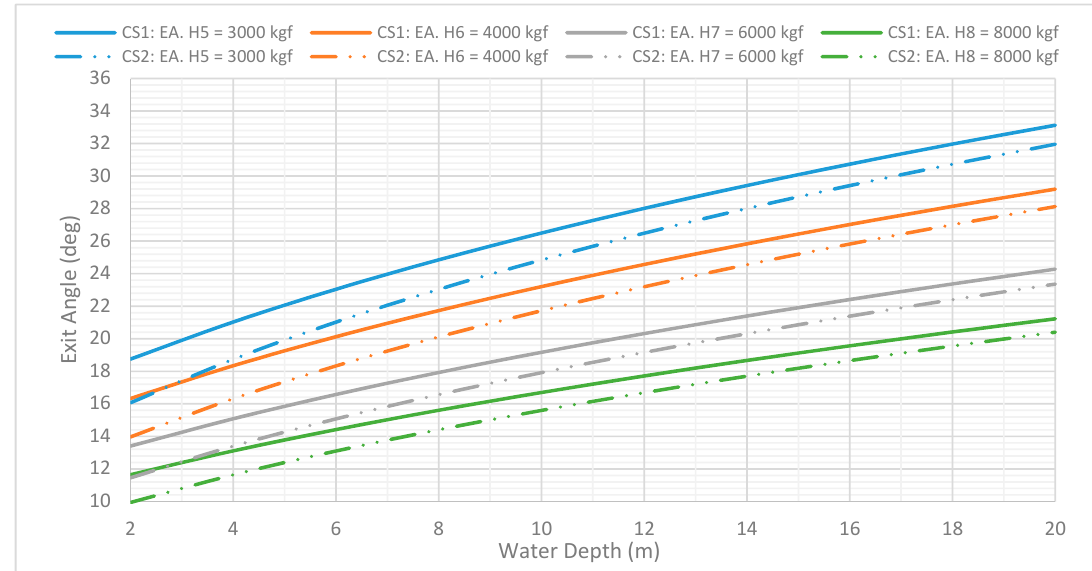
Figure 13. Exit angle ( θ ) assuming CS1 & CS2 using different bottom tensions (3000 kgf–8000 kgf) and water depths (2 m–20 m).